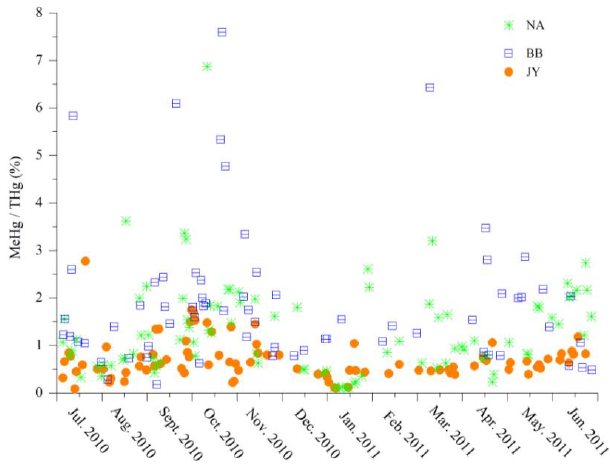
Fig. 4. The percent of THg present as MeHg in all precipitation events at 3